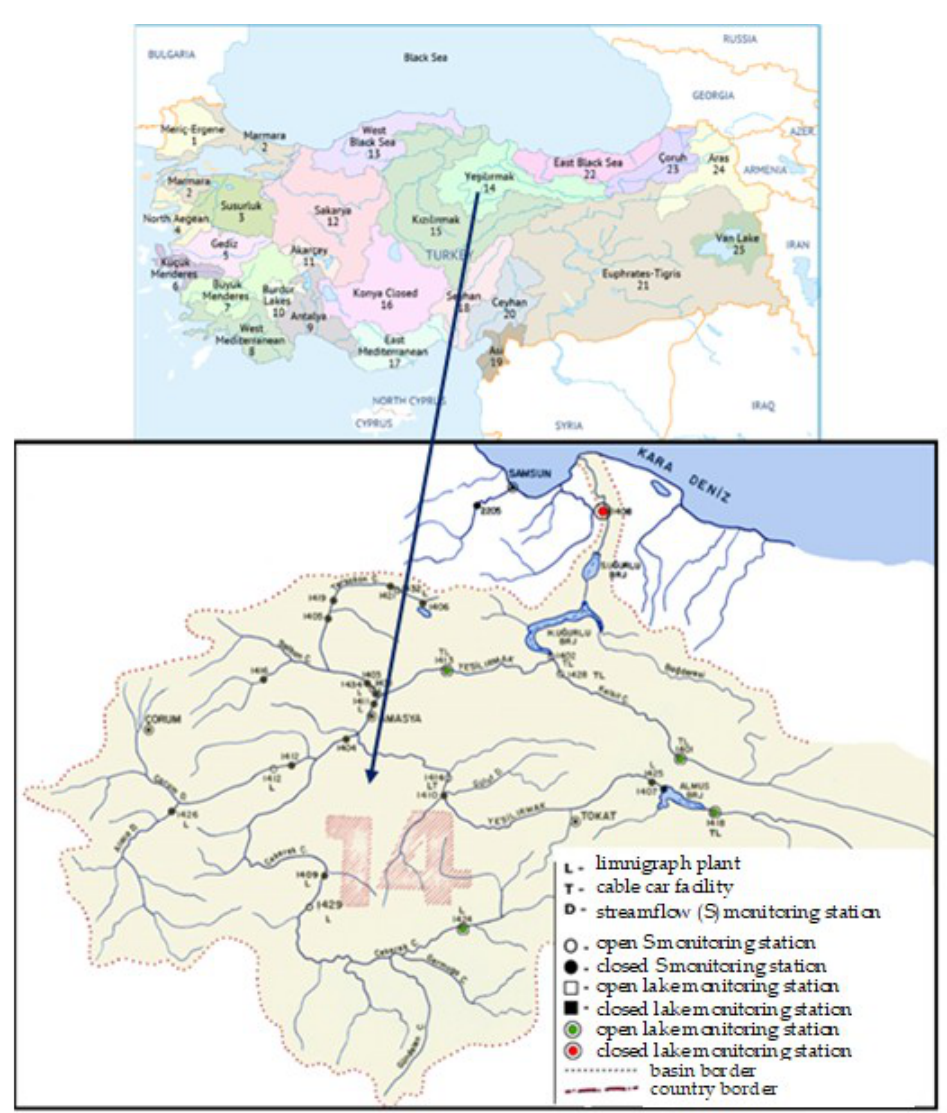
Figure 3. The location of the Durucasu (1413), Sutluce (1414) and Kale (1402), Yesilirmak Basin stations, situated in the Black Sea